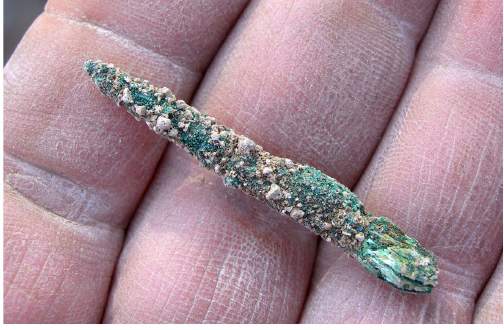
Figure 5. The metal awl from Tel Tsaf upon discovery.